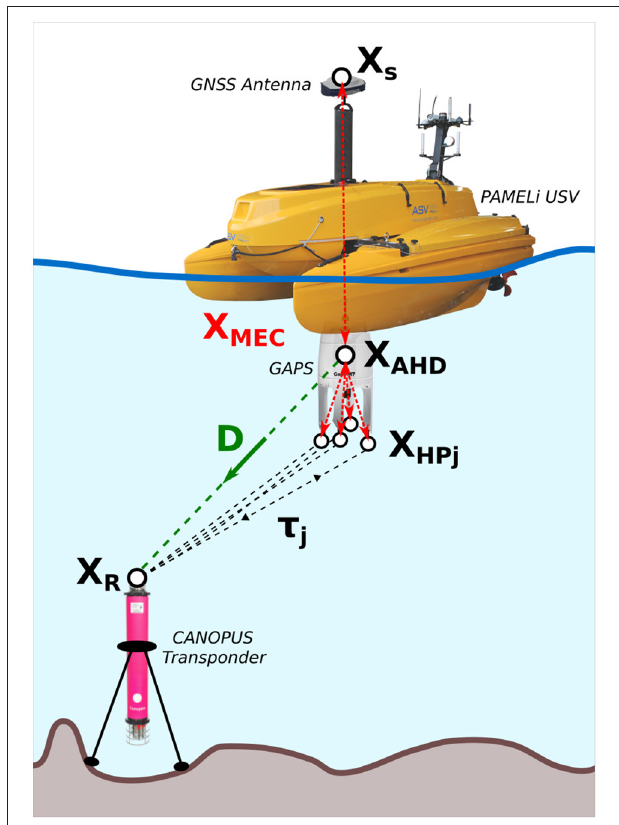
FIGURE 5 | Components and vector representation of the GNSS/A system (description in section